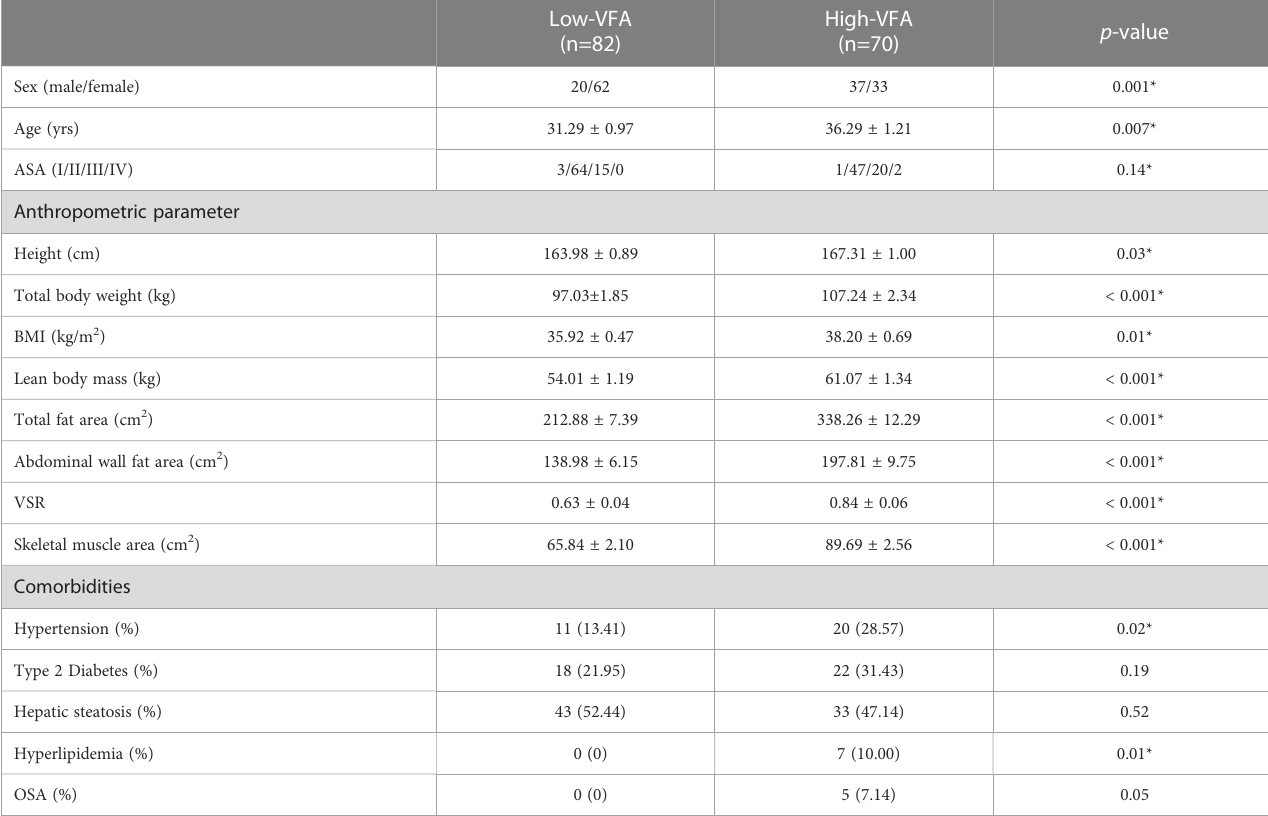
TABLE 1 Baseline characteristics of low-VFA vs. high-VFA